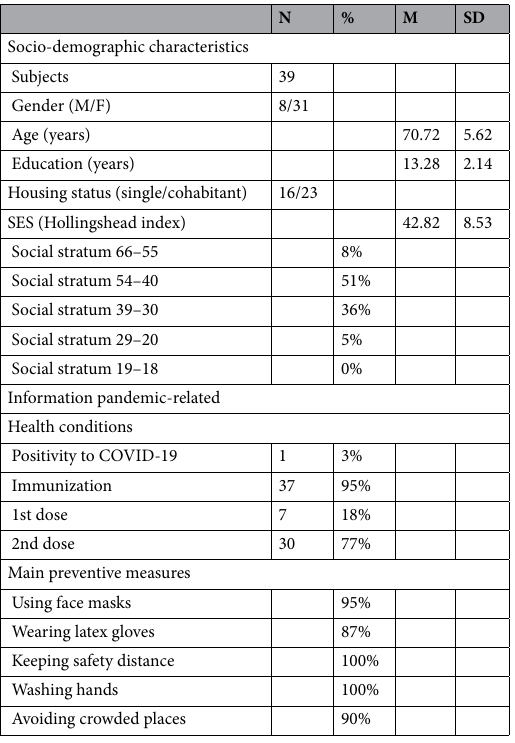
Table 1. Socio-demographic characteristics and health pandemic-related information of study participants. N number, M mean, SD standard deviation, M male, F female, SES socioeconomic